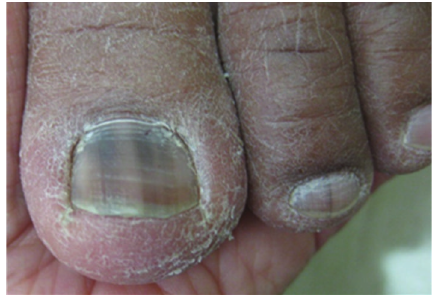
Figure 1: Racial melanonychia.